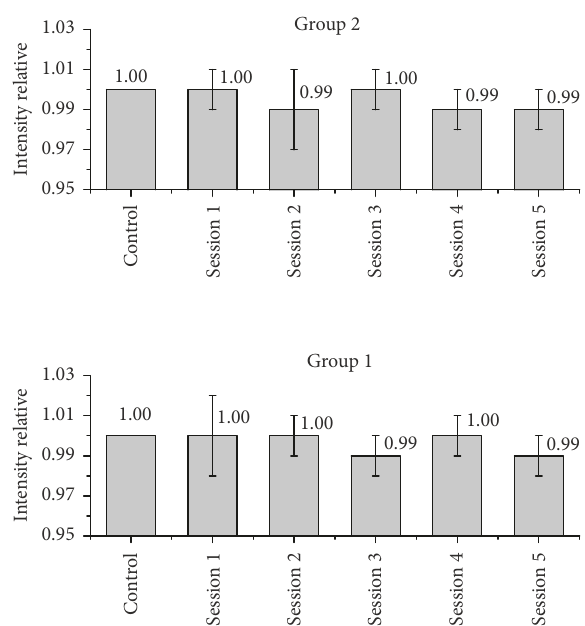
Figure 2: Relative intensity of calcium in the groups that were evaluated.